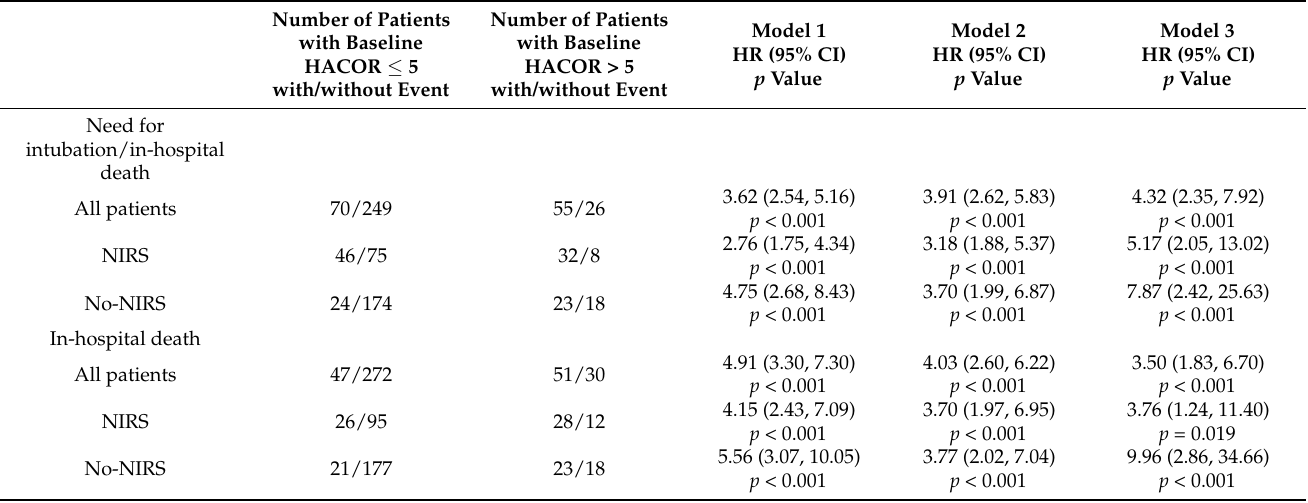
Table 3. Association between high baseline HACOR score, the need for intubation/in-hospital death, and in-hospital death in the entire study population and in the NIRS and no-NIRS subgroups. Number of Patients Number of Patients Model 1 with Baseline with Baseline HR (95% CI) HACOR ≤ 5 HACOR > 5 with/without Event with/without Event